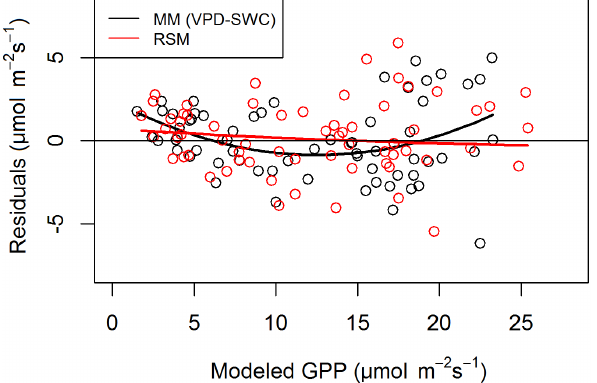
Figure 8. Plot between residuals of both the meteo-driven model (MM-VPD) and remote-sensing-based method (RSM) and modeled GPP values. Both lines represent the local polynomial regression fitting of the residuals against predicted